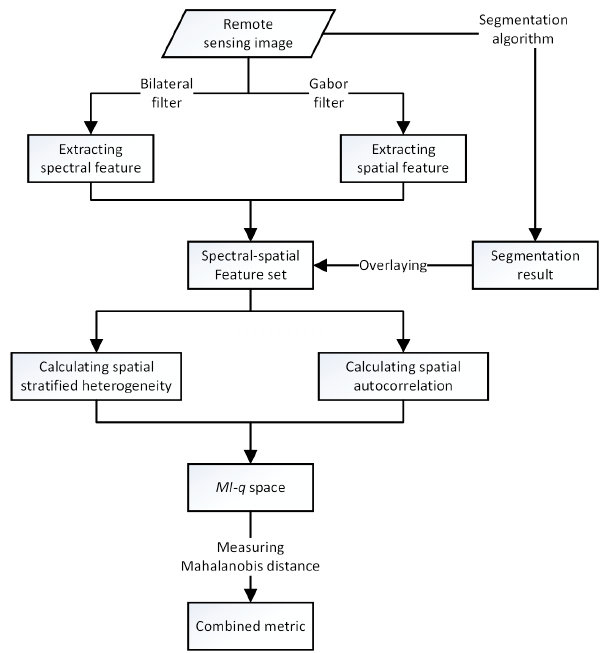
Figure 1. Flowchart of the proposed method to evaluate segmentation quality.